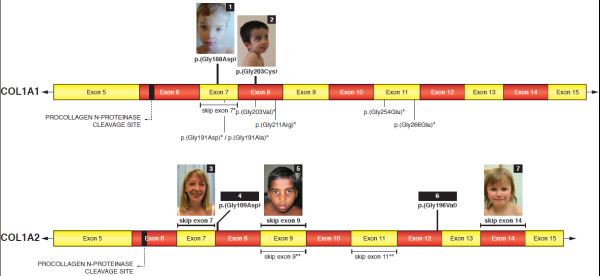
Schematic localisation of the OI/EDS-associated COL1A1 and COL1A2 mutations reported in the present study (on top of bar) and previously published (below bar). * [7], ° [14], ** [10,11], °° [8].